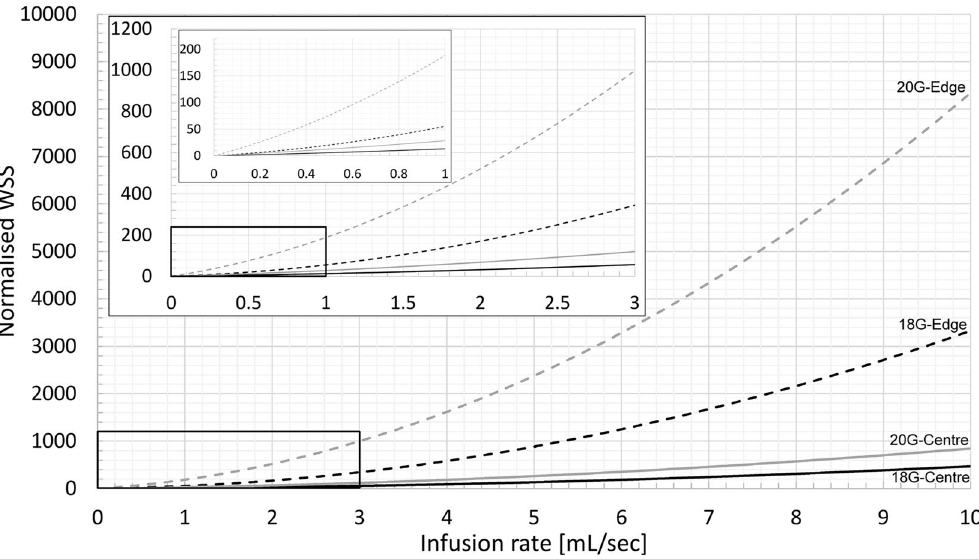
Figure 6. Effect of infusion rate through a 18 and 20 G catheter positioned centrally or at the vessel edge on the normalized wall shear stress in the